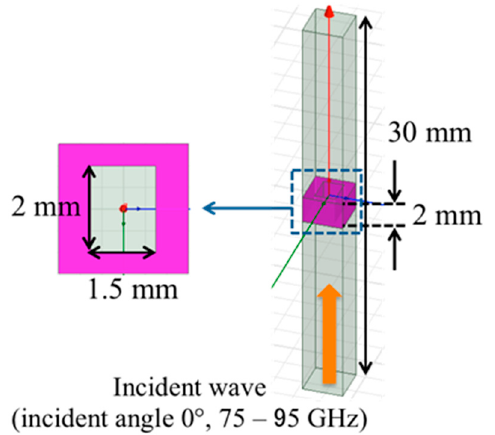
Figure 5. The MHA model for numerical analysis of the frequency characteristics of reflectance and transmittance.